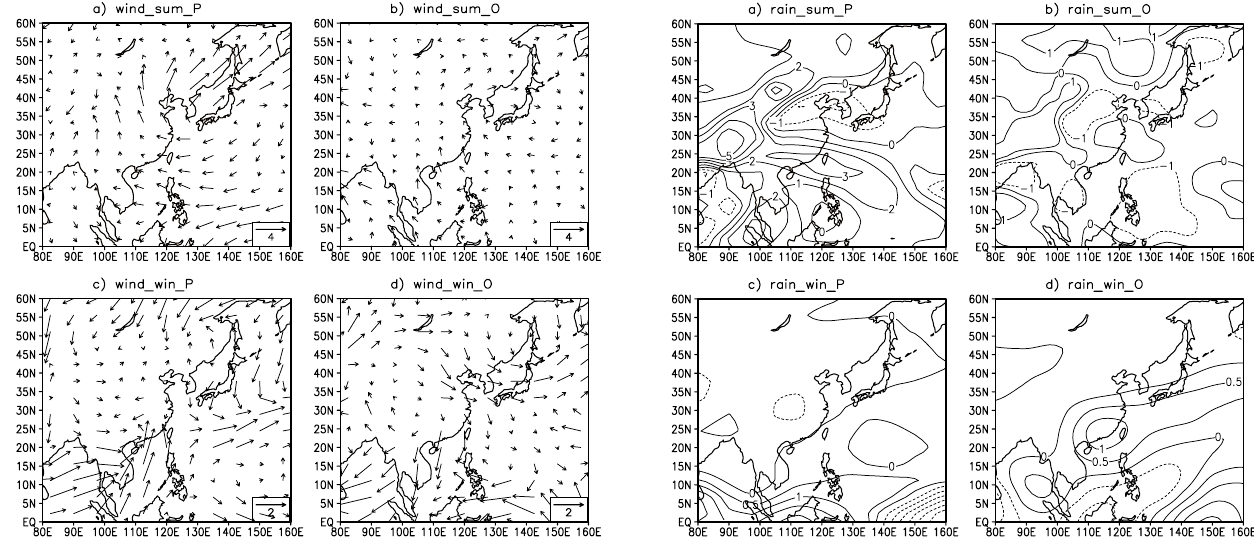
Fig. 6. Same as Fig. 3, but for surface wind vectors (ms − 1 ). Fig. 7. Same as Fig. 3, but for precipitation rate (mmd